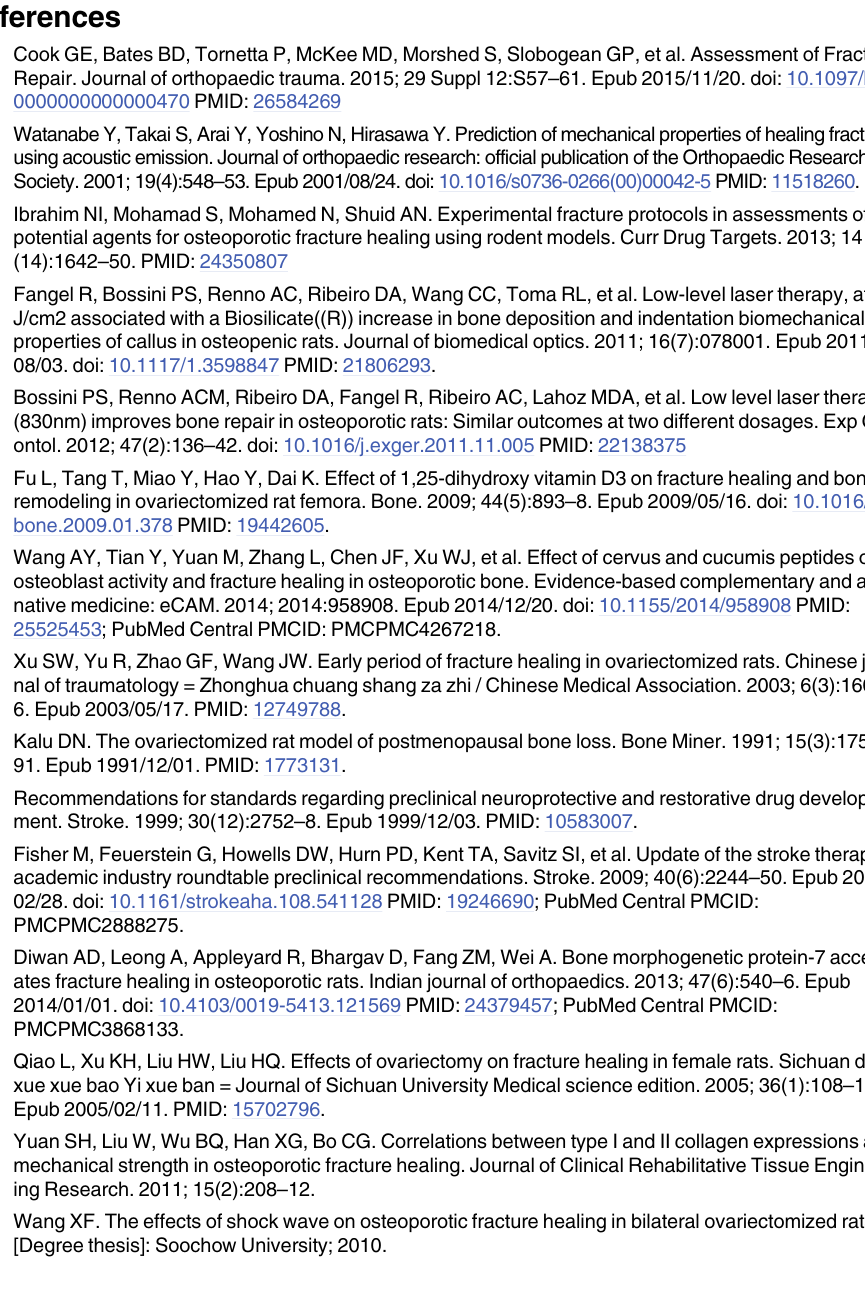
S4 Fig. The combined quadratic curves between maximum load and fracture healing time of rats < = 12 weeks old and > 12 weeks old at the time of